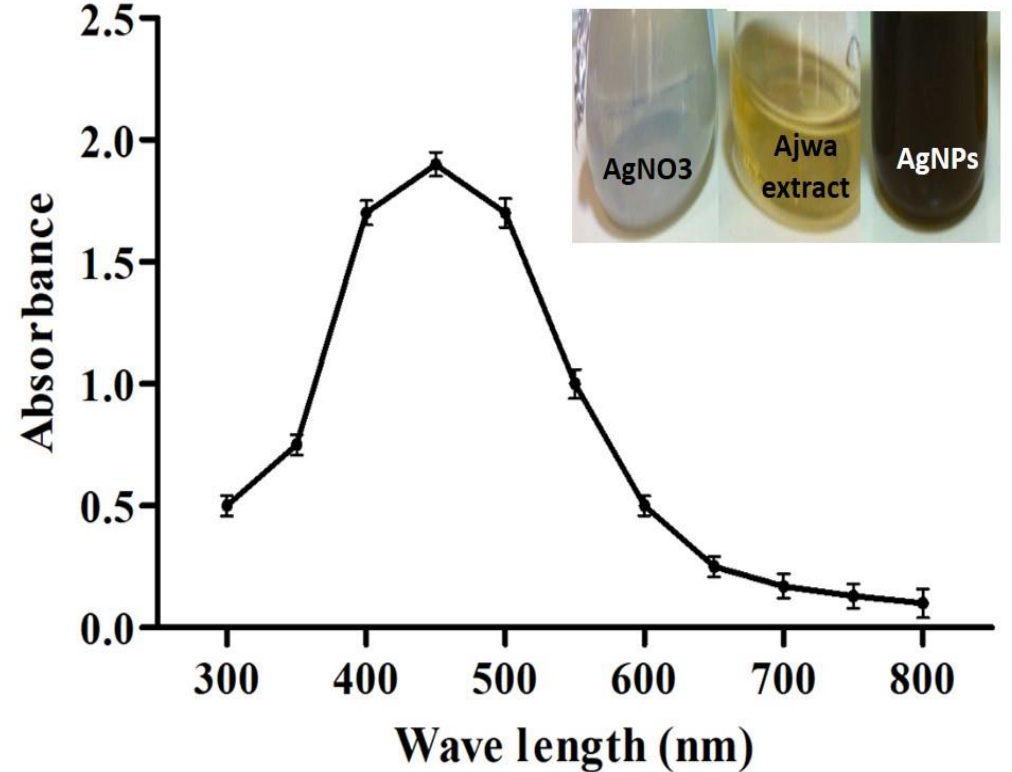
Figure 1. UV spectrum of the AgNPs synthesized from Ajwa date seed extract. Values expressed as mean ± SE of the mean ( n = 3). (Inset: change in color from pale yellow to tan-brownish color).